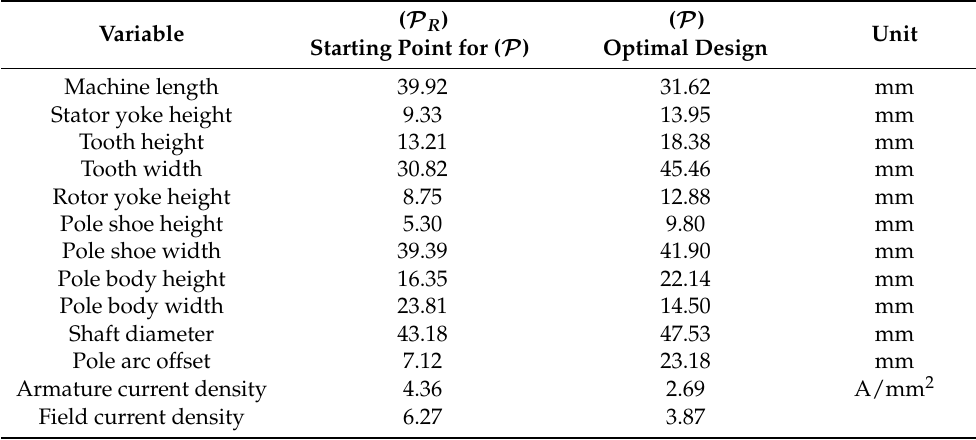
Table 3. Optimized Variables.